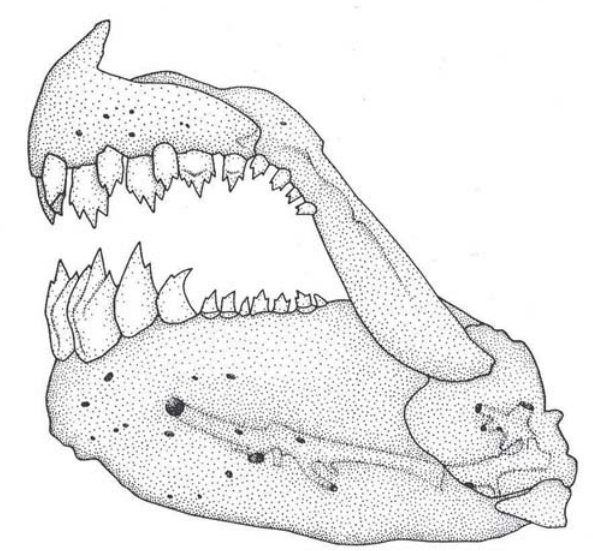
Fig. 28. Glandulocauda caerulea , adult male, USNM 326756, 39.4 mm SL; jaws and dentition, lateral view, right side, anterior at